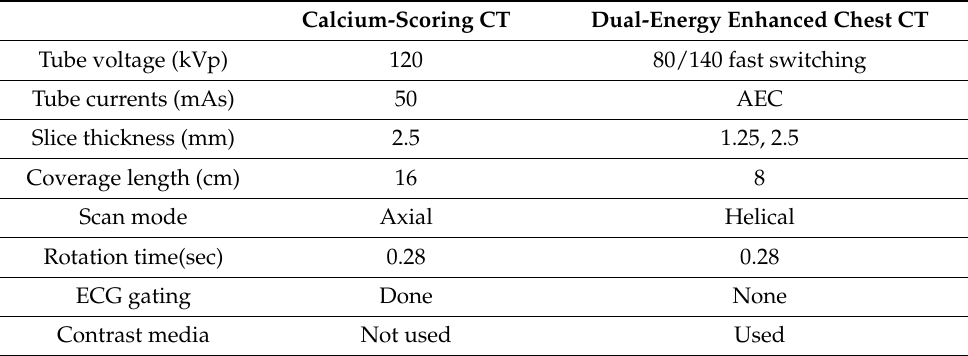
Table 1. Protocols for calcium-scoring CT and chest